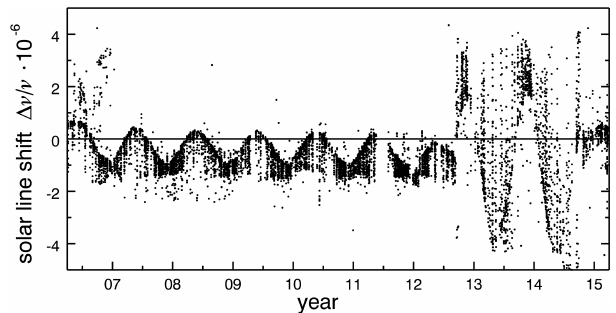
Figure 5. Time series of solar line shifts determined from Zugspitze FTIR spectra in the 2400 < ν < 3100cm − 1 optical